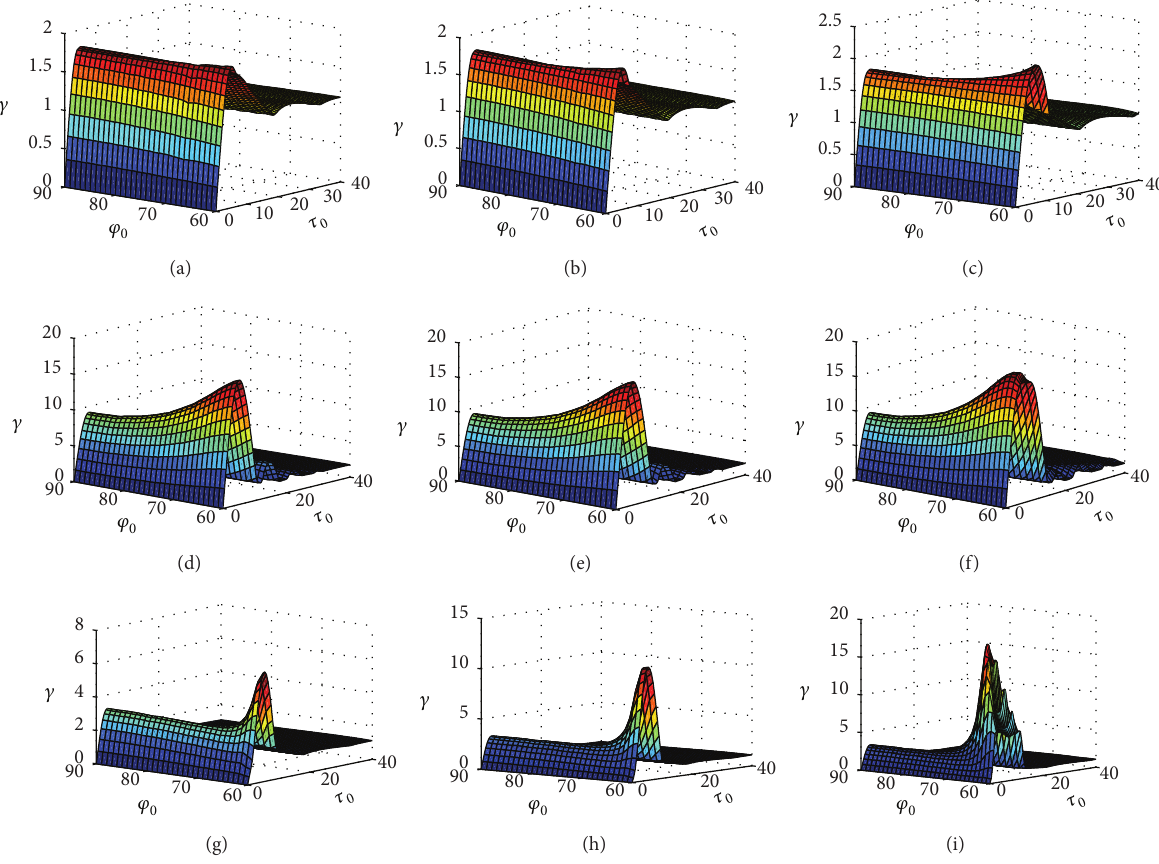
Figure 8: The effect of the peak pulse acceleration and frequency parameter ratio on three-dimensional shock response spectrum of critical components: (a) 𝛽 ̈𝑢 0𝑚 = 0.05 , 𝜆 1 = 10 ; (b) 𝛽 ̈𝑢 0𝑚 = 0.1 , 𝜆 1 = 10 ; (c) 𝛽 ̈𝑢 0𝑚 = 0.2 , 𝜆 1 = 10 ; (d) 𝛽 ̈𝑢 0𝑚 = 0.05 , 𝜆 1 = 0.85 ; (e) 𝛽 ̈𝑢 0𝑚 = 0.1 , = 0.85 ; (f) 𝛽 ̈𝑢 = 0.2 , 𝜆 = 0.85 ; (g) 𝛽 ̈𝑢 = 0.05 , 𝜆 = 1.7 ; (h) 𝛽 ̈𝑢 = 0.1 , 𝜆 = 1.7 ; (i) 𝛽 ̈𝑢 = 0.2 , 𝜆 = 1.7 𝜆 1 0𝑚 1 0𝑚 1 0𝑚 1 0𝑚 1